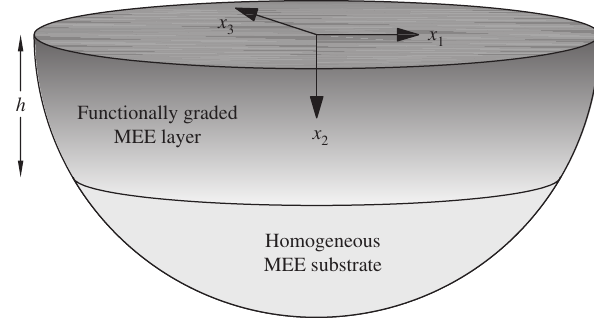
Figure 1: FGMEE layer on homogeneous MEE